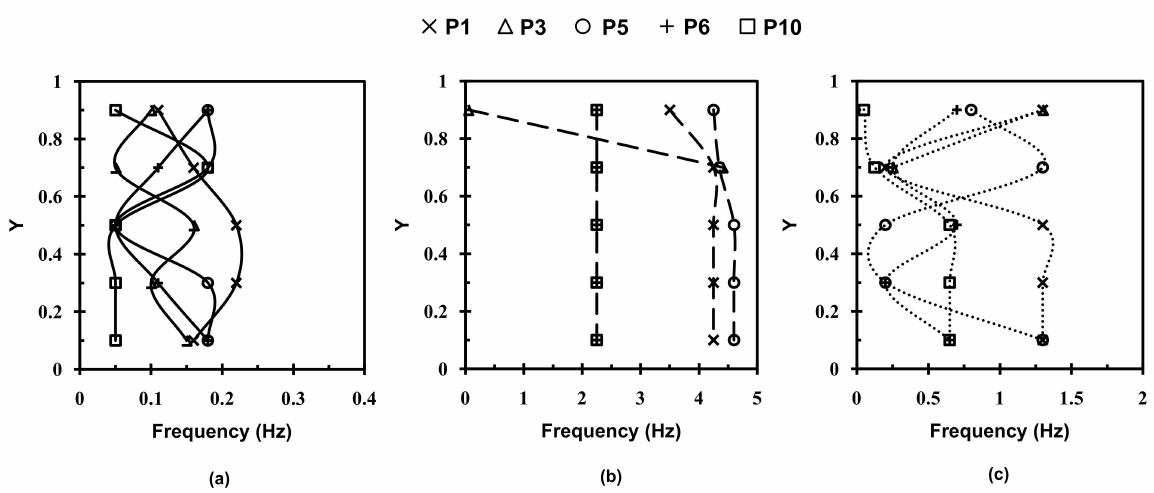
Figure 16. Overall trends of predicted basic frequency of velocity fluctuations at five monitoring locations. ( a ) Case 1, ( b ) case 2 and ( c ) case